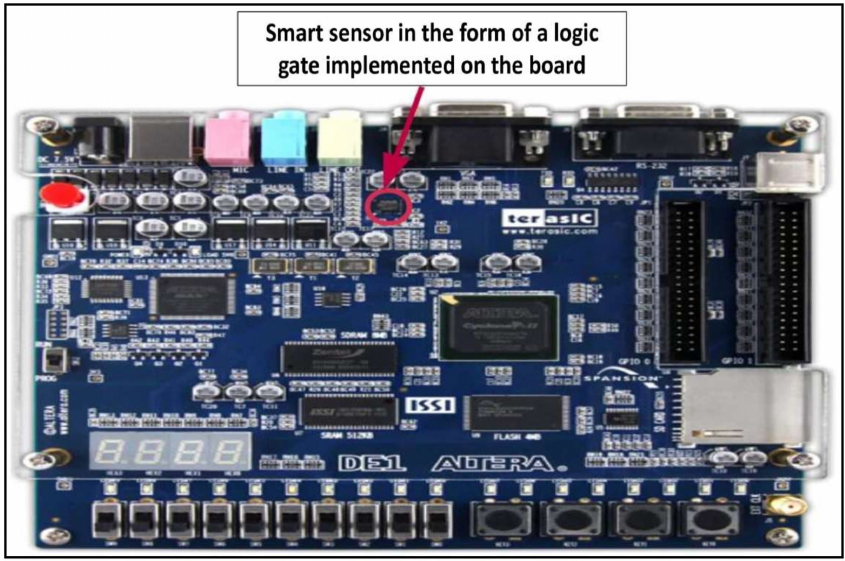
Figure 11. Validation of simulation and implementation of the smart monitoring system results on the liquid-crystal display (LCD) of DE1 Altera Cyclone